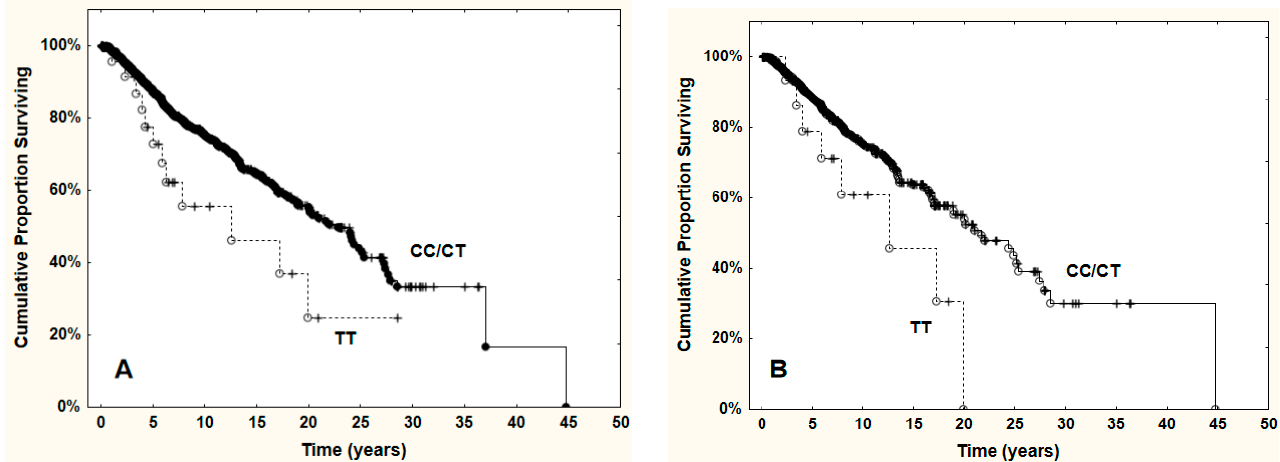
Figure 1. ( A ) Probability of survival in subjects with PMF stratified for the VEGFA rs3025039 polymorphism genotypes. ( B ) Probability of survival in subjects with PMF bearing the JAK2 V617F mutation, stratified for the VEGFA rs3025039 polymorphism genotypes. The subjects with the TT genotype had a shorter survival than those with the CC or CT genotype ( p = 0.029 and p = 0.036, respectively).